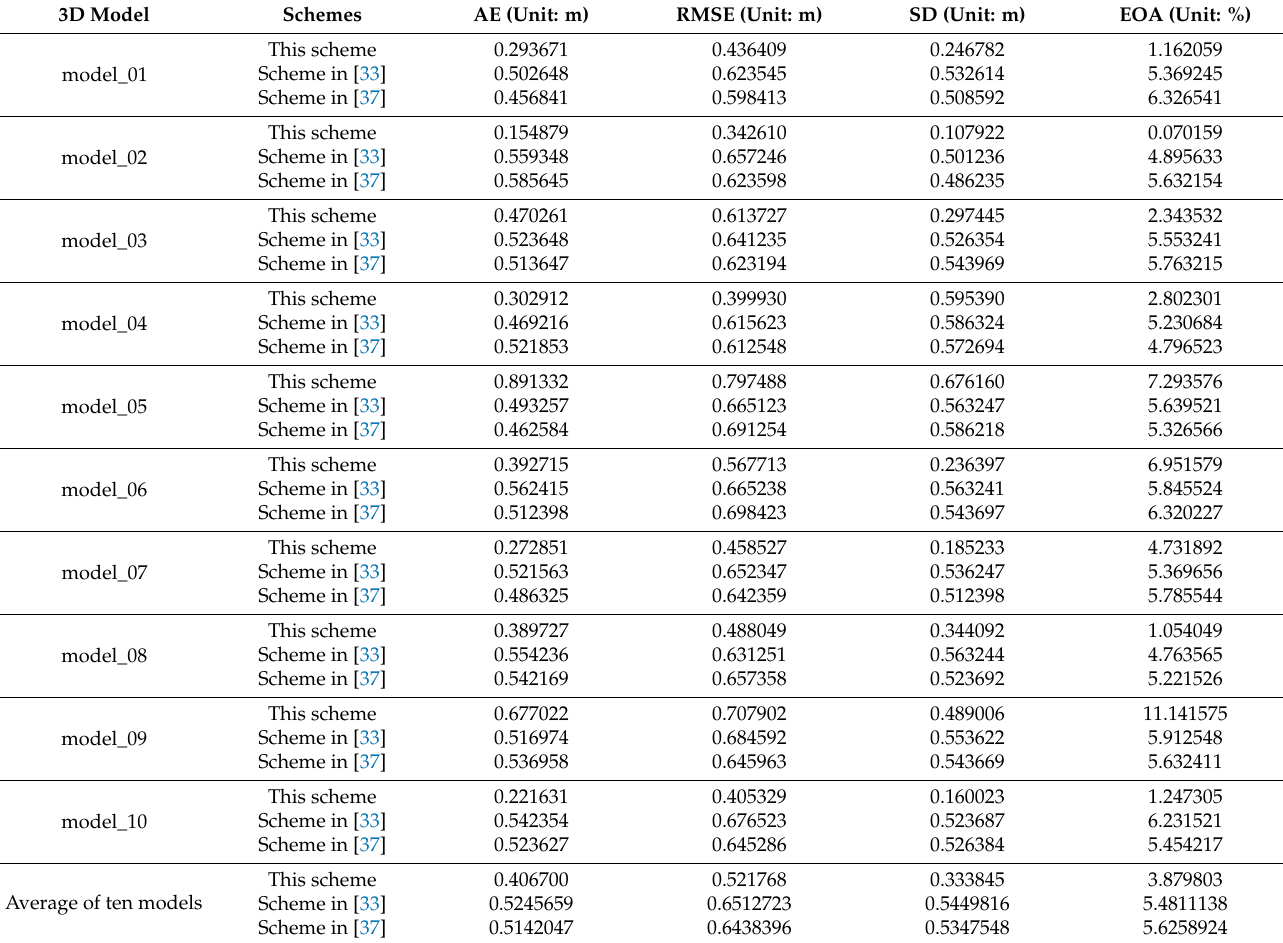
Table 2. Comparison results of accuracy of water boundary